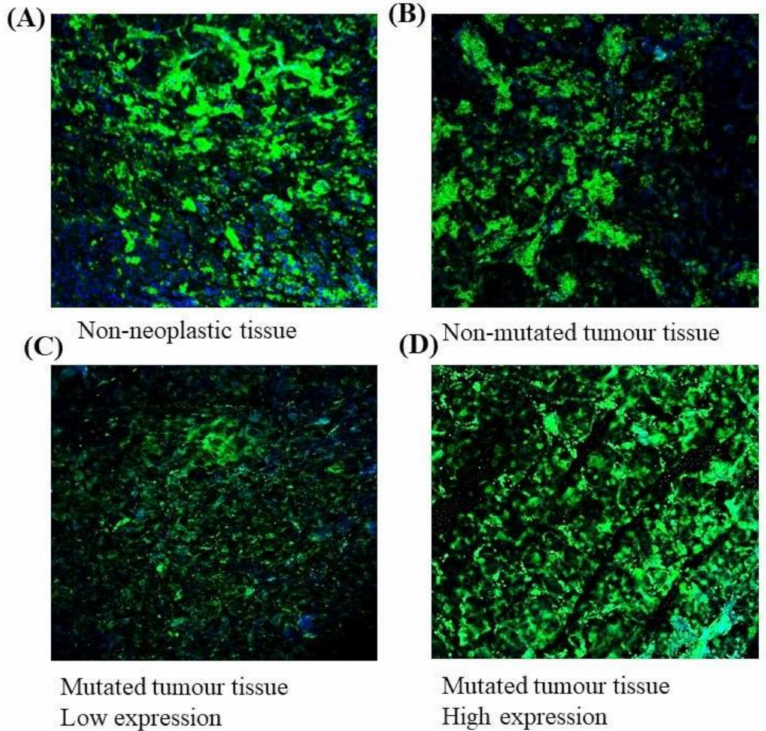
Figure 4. EPAS1 protein expression in tumours and non-neoplastic tissues. Representative EPAS1 immunofluorescencestainingunderconfocalmicroscopy.( A )Non-neoplasticadrenaltissue. ( B )Tumour tissue with no EPAS1 mutation. ( C ) Mutated tumour tissue with low EPAS1 expression. ( D ) Mutated tumour tissue with high EPAS1